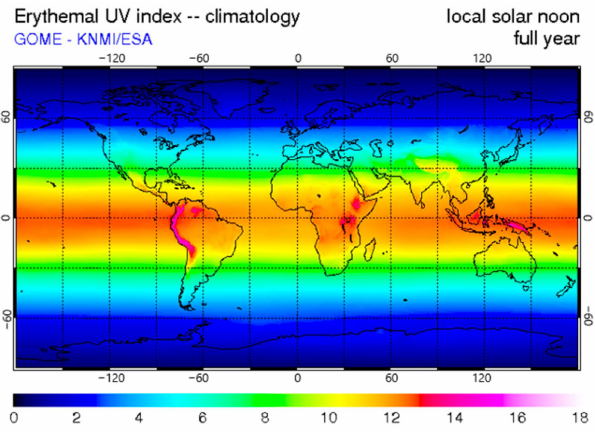
Figure 1. Global UV index map from 1996 to